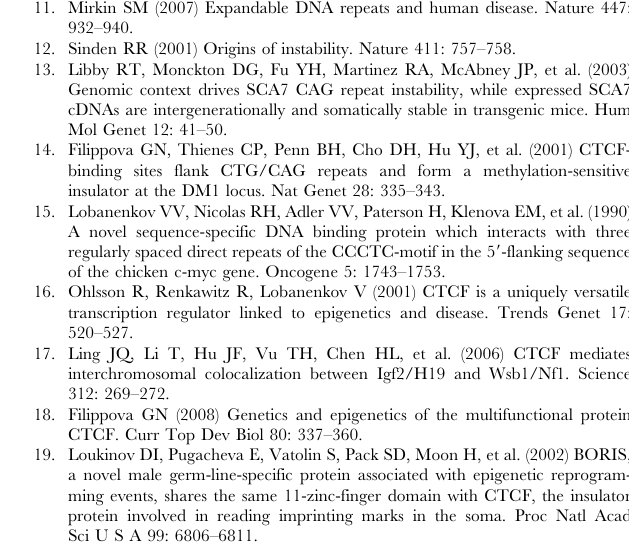
filled circles corresponds to a critical CTCF contact site, based upon footprinting analysis (see Figure 1C). Figure S7 Epigenotype data for bisulfite sequencing analysis of the CTCF-I binding site region in SCA7-CTCF-I -wt transgenic liver. Results of bisulfite sequencing analysis for liver DNAs obtained from three SCA7-CTCF-I -wt transgenic mice reveal moderate to high levels of CpG methylation in this tissue, especially when compared to the completely un-methylated status of CpG dyads observed in all tail DNAs and kidney DNAs, with one exception. Figure S8 Methylation of the SCA7-CTCF-I site abrogates binding of BORIS as well as CTCF. Gel retardation assays with unmethylated or Sss I-methylated SCA7-CTCF-I -wt probe frag- ments were performed with probe only, the 11 zinc-finger DNA binding domain region of CTCF, CTCF with pre-immune anti- CTCF sera (CTCF + pI), CTCF protein with anti-CTCF sera (CTCF + a -CTCF), BORIS with pre-immune anti-BORIS sera (BORIS + pI), or BORIS protein with anti-BORIS sera (BORIS + a - BORIS). Arrows indicate shifted CTCF-DNA complexes and shifted BORIS-DNA complexes. Methylation of the SCA7- CTCF-I probe fragment abrogates all binding. Success of Sss I methylation was confirmed by Nru I restriction digestion (see Figure S5). Found at: doi:10.1371/journal.pgen.1000257.s008 (2.87 MB